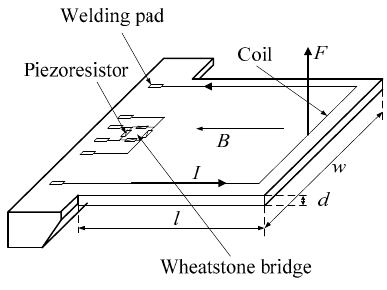
Figure 1. Schematic diagram of the micro-cantilever resonant sensor.